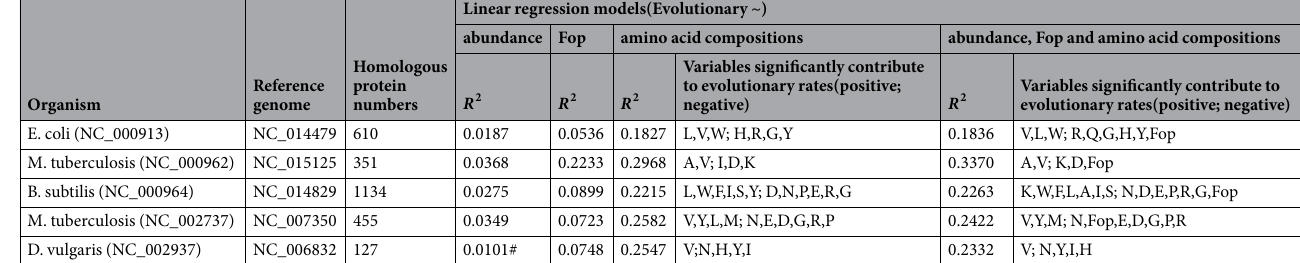
Table 1. The linear models for evolutionary rates and abundance/Fop/amino acid compositions. * All MLRs in this table have P values less than 0.05. # This linear model has P = 0.45, which is